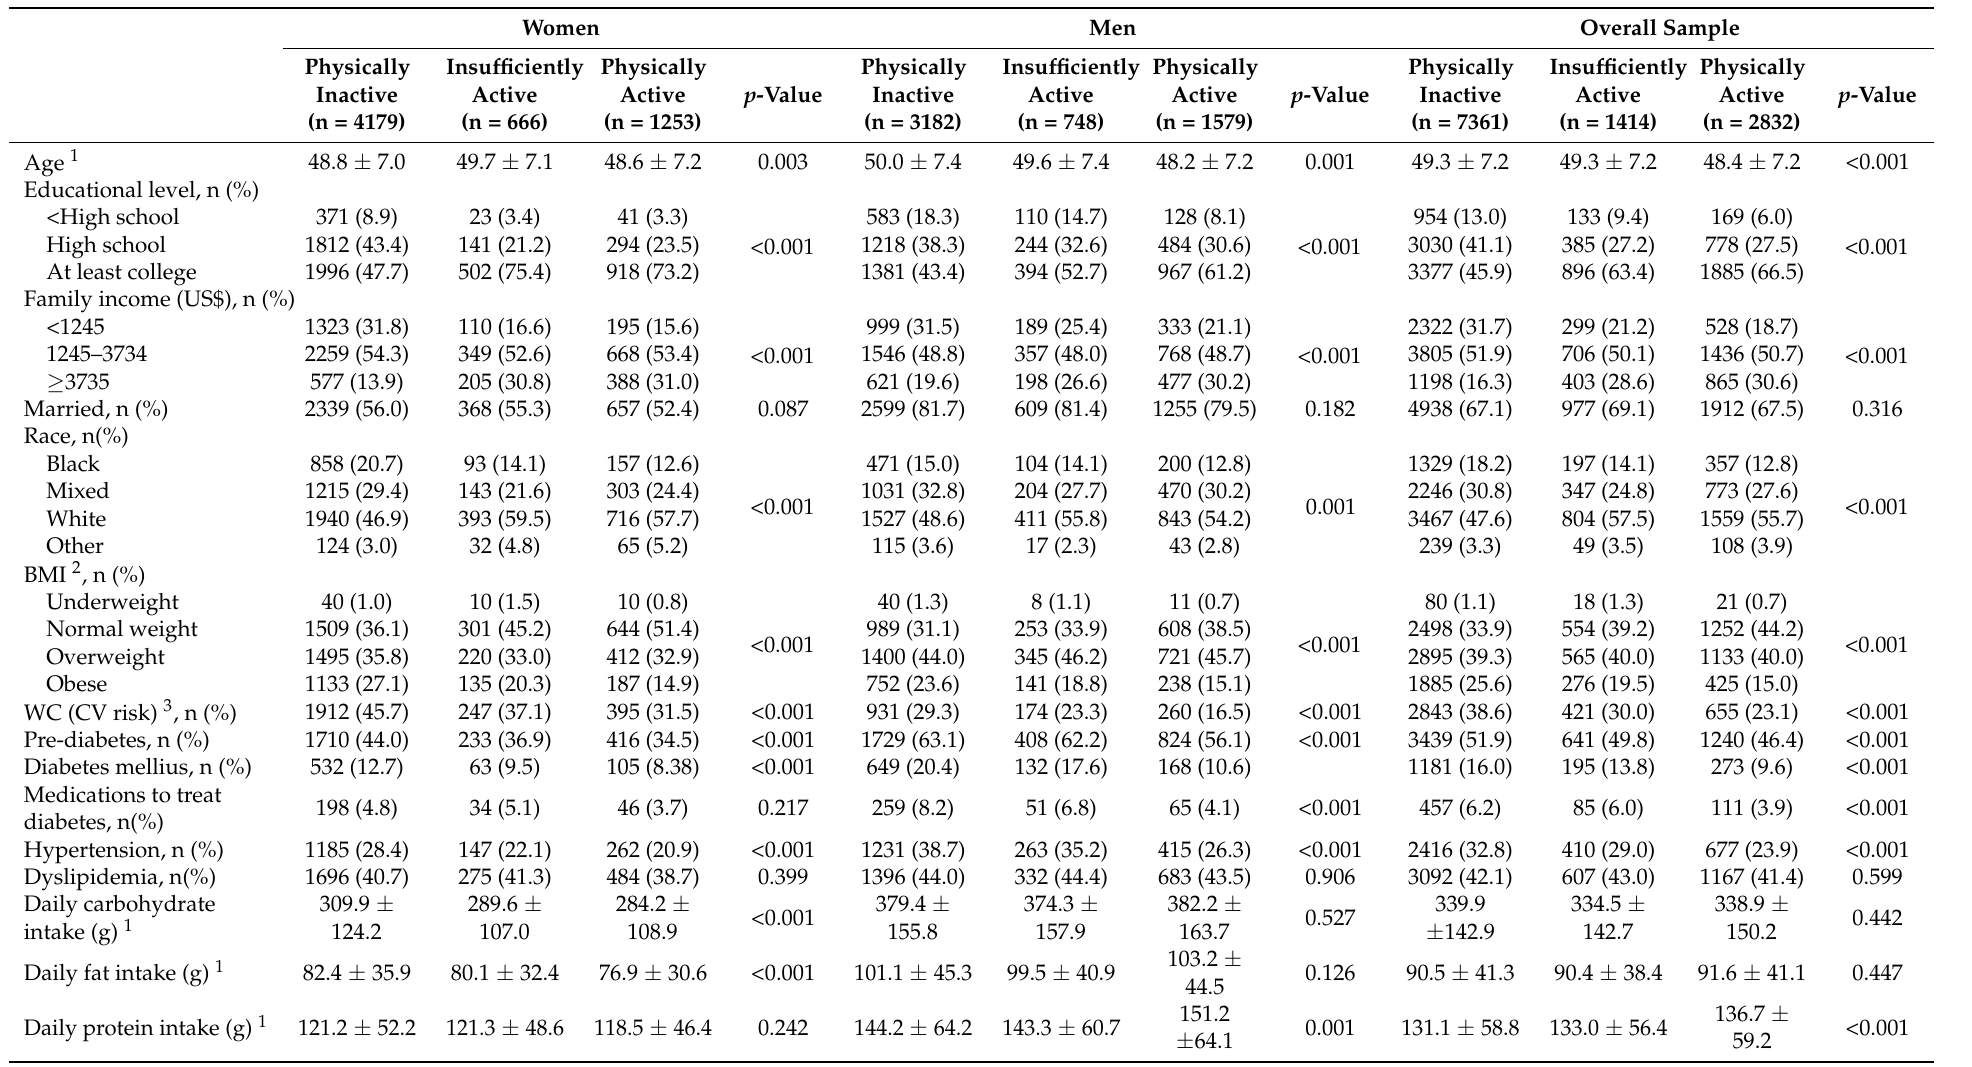
Table 1. Descriptive characteristics according to physical activity level at leisure-time in baseline participants of ELSA-Brasil study (n = 11,797). Women Men Overall